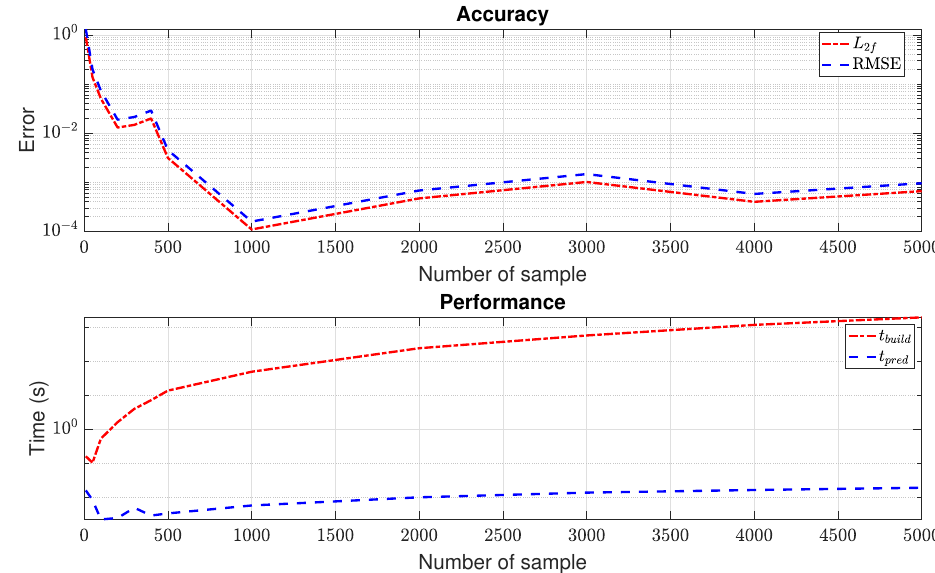
Figure 4. Relative errors and computational time of the Kriging model for different sampling numbers.